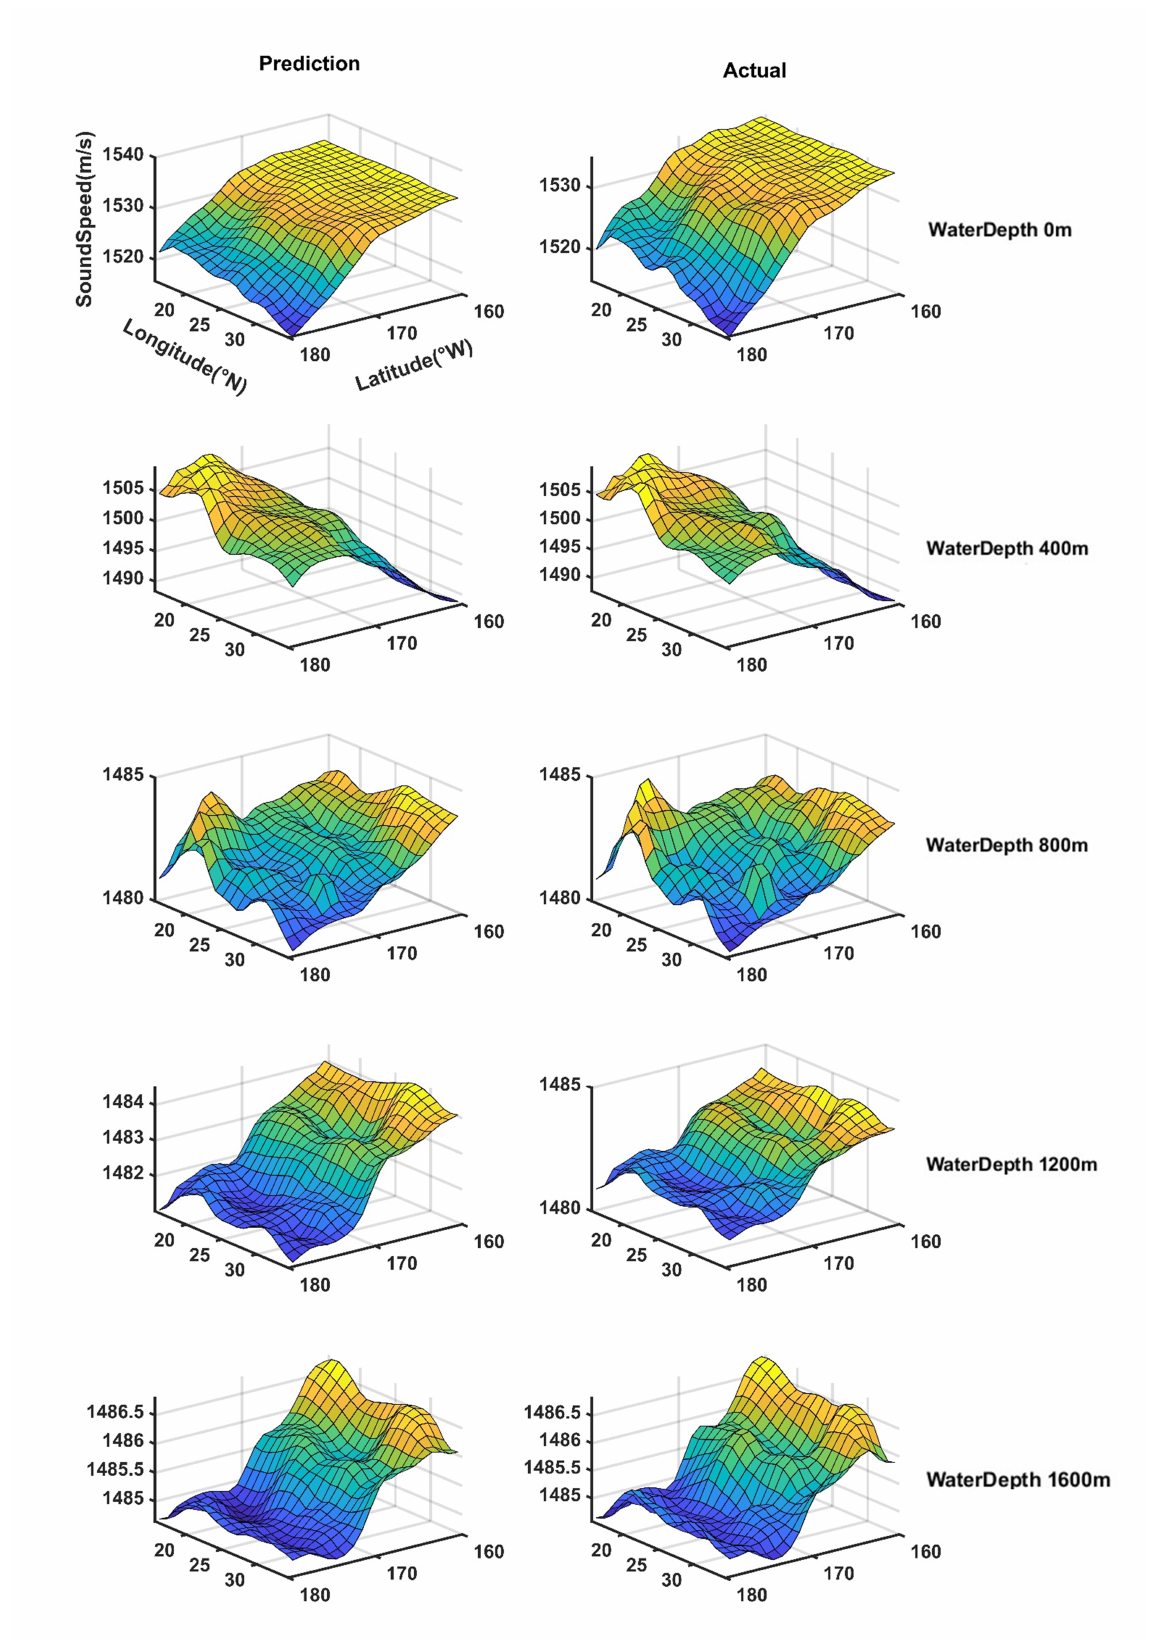
Figure 10. Prediction of different water depth in the chosen